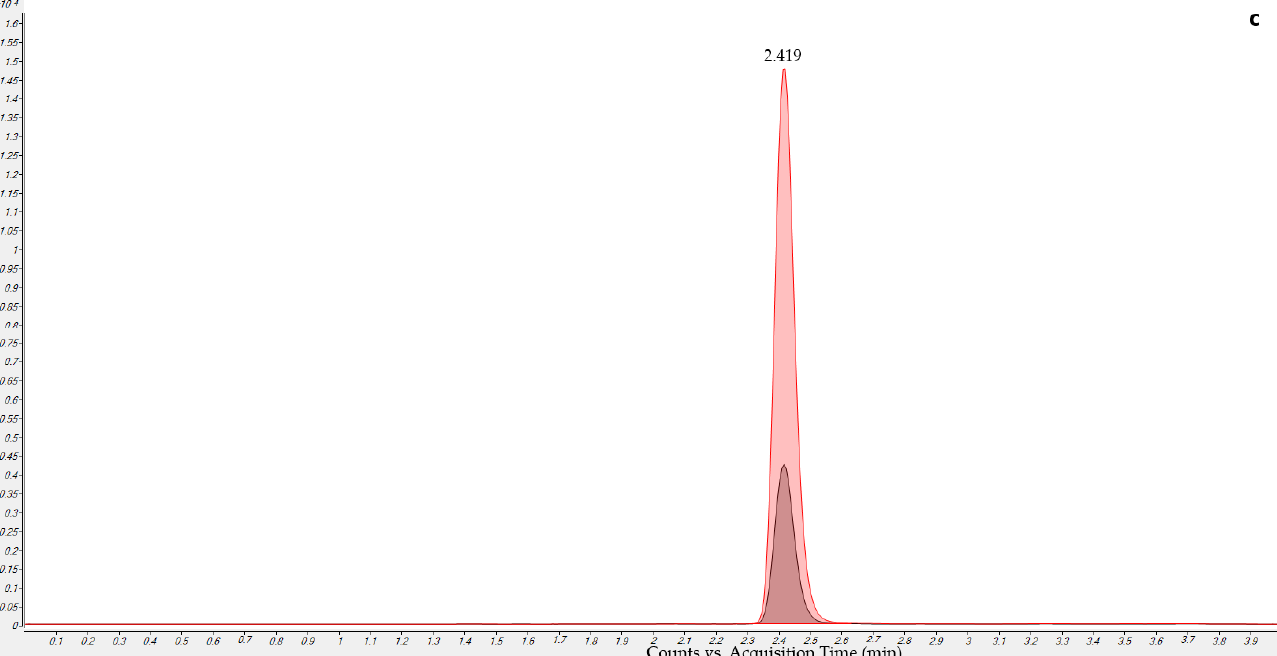
Figure 4. Overlayed MRM chromatograms for DBV (black) and DBV-d6 (red) obtained in the analysis of different samples. ( a ) blank sample extracted with the methanol-IS solution showing a well- defined DBV-d6 peak without any DBV peak; ( b ) LLOQ sample with the respective S/N ratio (SNR); ( c ) patient sample collected 25 days after starting DBV showing good peak shape and resolution for both DBV and DBV-d6.